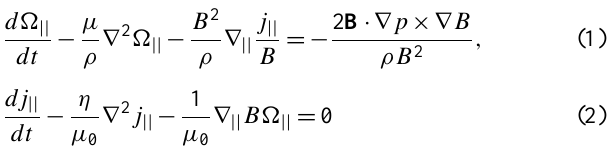
(black streamlines) superposed on the color contour of d(cid:127) ||